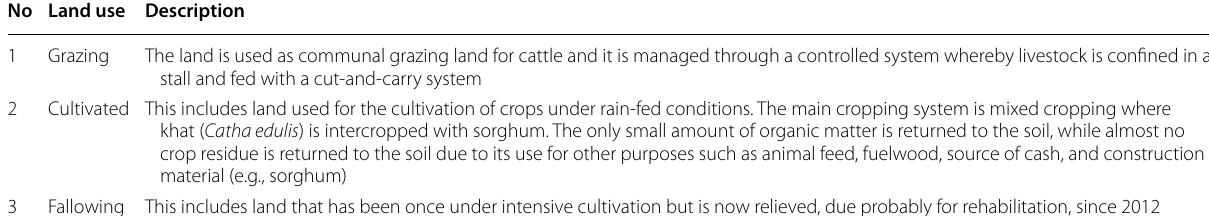
Table 1 Description of land use types observed within Kersa sub-watershed in eastern Ethiopia No Land use